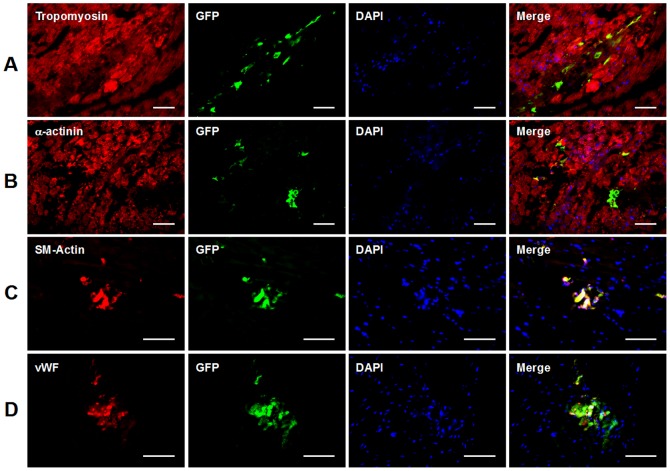
Immunofluorescence analysis of ADSC differentiation after transplantation in post-MI heart.A-B: Sections of hearts were triple-stained with DAPI (nuclei), antibodies to GFP and cardiomyocyte markers tropomyosin (A) or α-actinin (B) 4 weeks post-transplantation. C: Sections of hearts were triple-stained with DAPI, antibodies to GFP and smooth muscle cell marker smooth muscle actin (SMA) 4 weeks post-transplantation. D: Sections of hearts were triple-stained with DAPI, antibodies to GFP and endothelial cell marker von-Willebrand Factor (vWF) 4 weeks post-transplantation. Scale bars represent 50 µm. DAPI: 4′,6-diamidino-2-phenylindole.